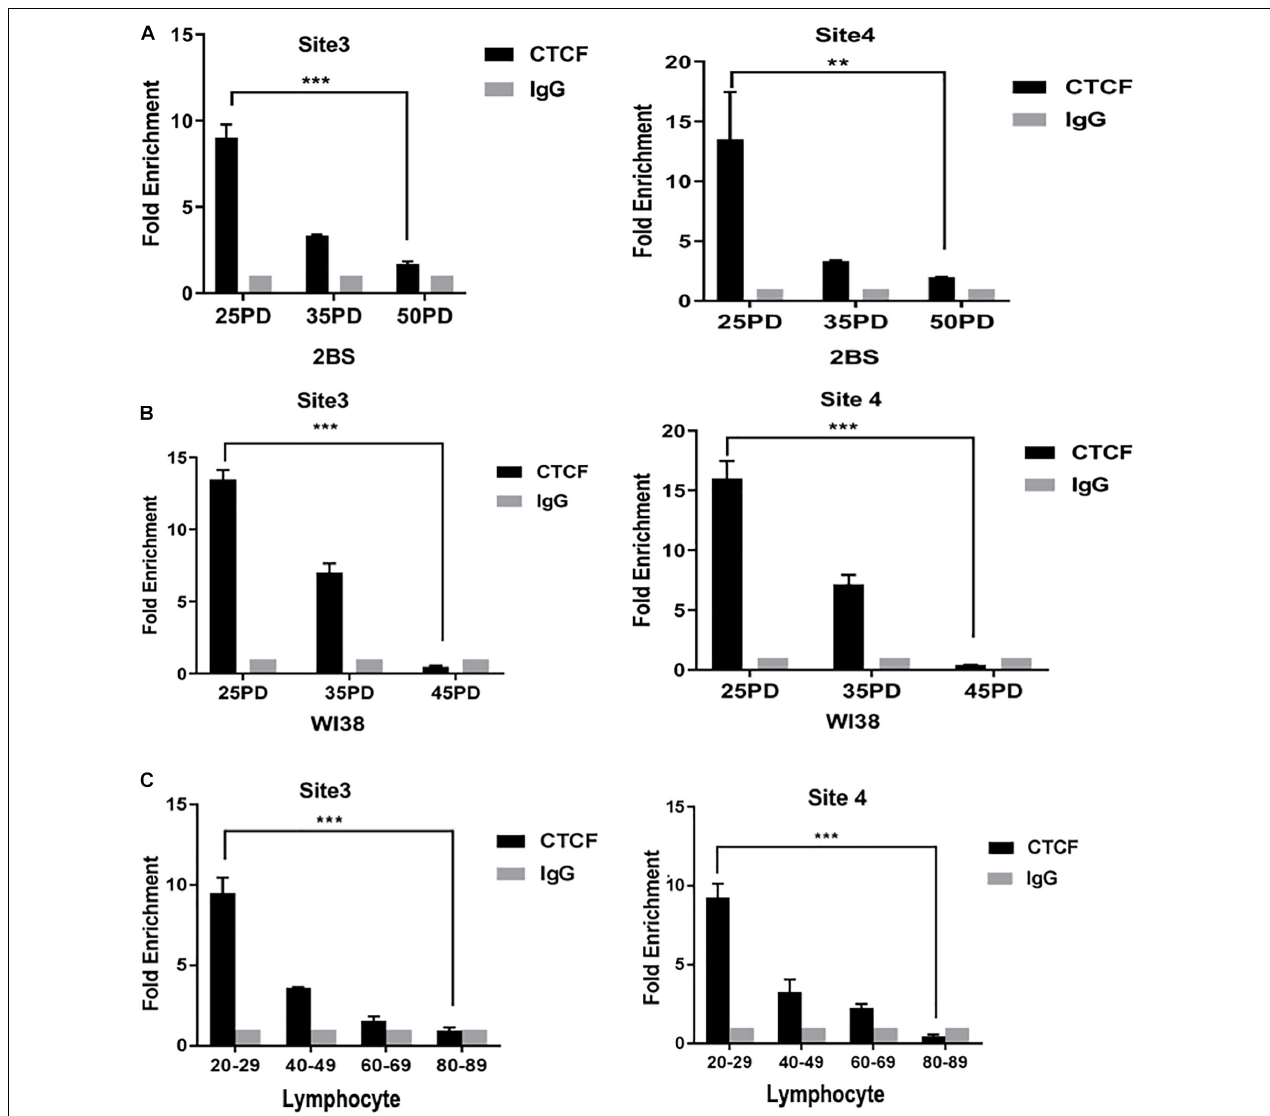
FIGURE 3 | The binding level of CCCTC-binding factor (CTCF) in the DNA polymerase delta 1, catalytic subunit (POLD1) promoter decreased with aging. (A) Binding level of CTCF at the POLD1 promoter in 2BS cells from different population doublings (PDs). (B) Binding level of CTCF at the POLD1 promoter in WI38 cells from different PDs. (C) Binding level of CTCF at the POLD1 promoter in lymphocytes from healthy people of different ages. Densitometric analysis of the band intensity in different groups, normalized to the input. Data were compared using one-way ANOVA, and values represent the mean ± SEM with three independent experiments in each group. ** P < 0.01, *** P <